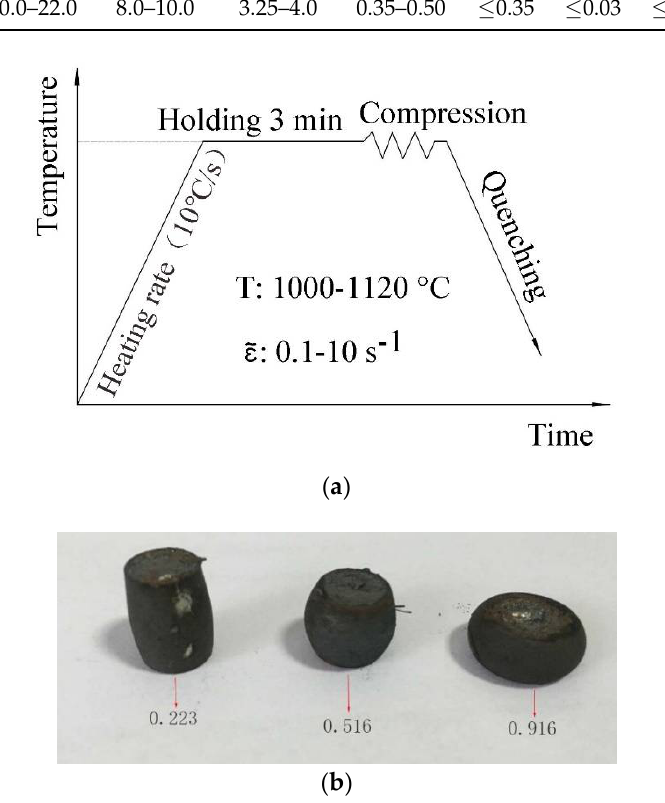
Figure 2. Compression tests of 21-4N. ( a ) Temperature profiles for the compression tests of 21-4N. ( b ) Specimens after the compression tests.